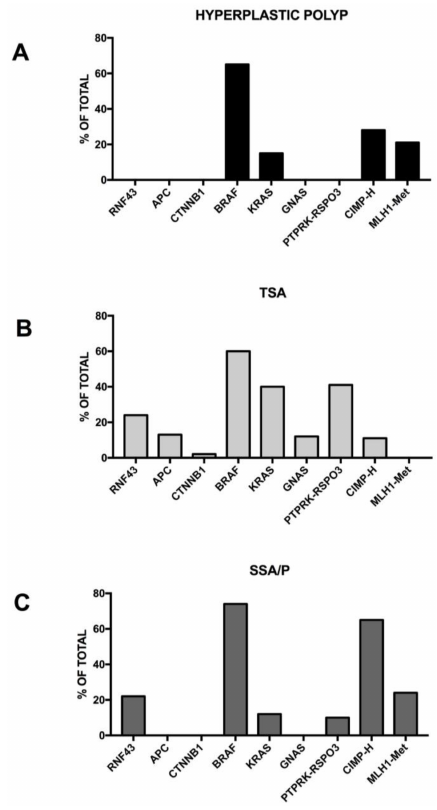
Figure 6. Frequent genetic alterations, CIMP-H and MLH1-methylated in hyperplastic polyps ( A ), traditional serrated adenomas (TSA) ( B ), and sessile serrated adenomas/polyps (SSA/P) ( C ). The data are reported by Sekine and coworkers